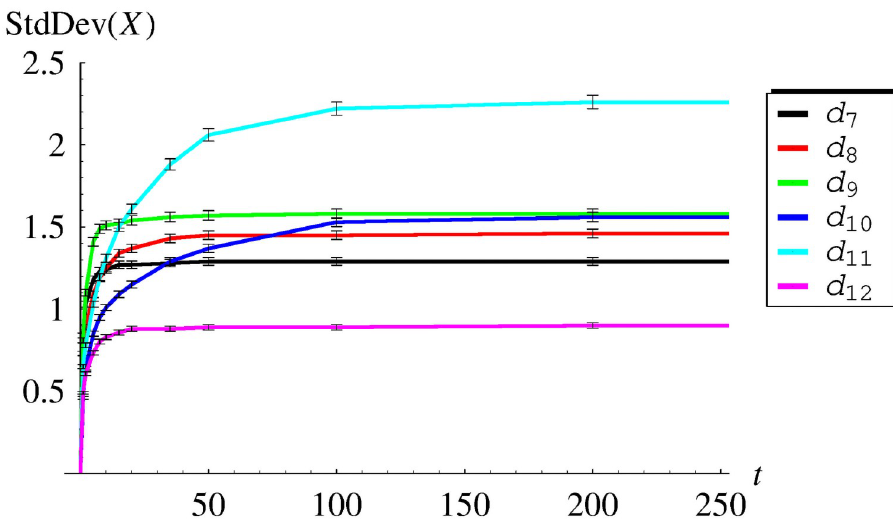
Fig 4. The standard deviation of the queue size versus time for dropping functions d 7 − d 12 . The confidence intervals for the confidence level of 0.99 are added.